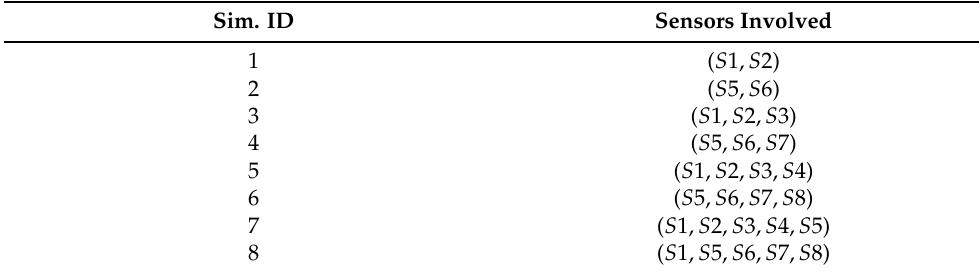
Table 2. Simulation experiments parameters.